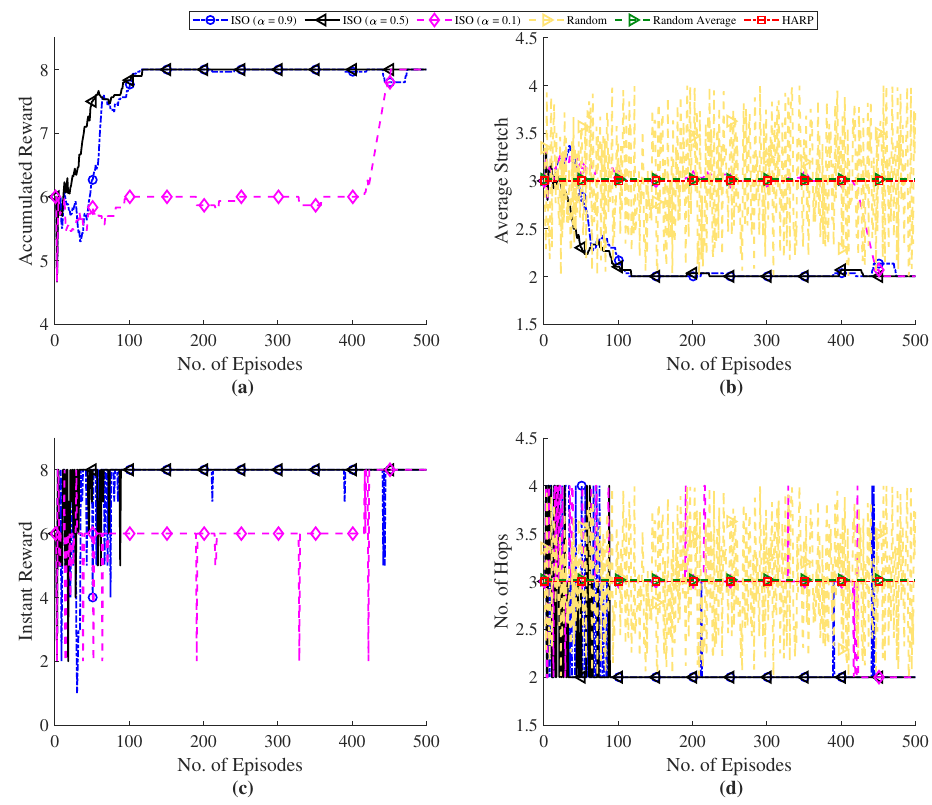
Figure 8. Stretch reduction and routing optimization progress of Q-learning agent at γ = 0.9: ( a ) Accu- mulated reward gain; ( b ) Average stretch gain; ( c ) Reward earned per episode; ( d ) Total hops/routers covered per